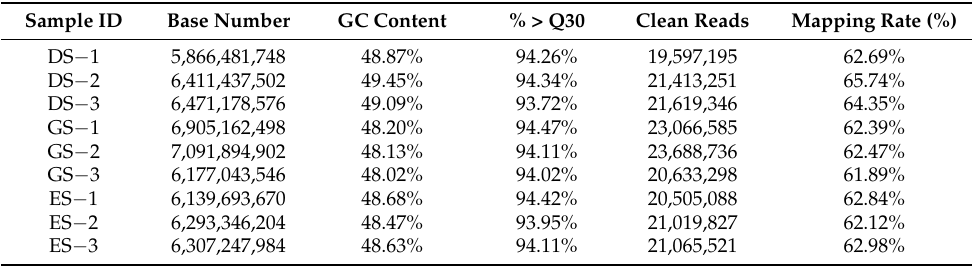
Table 1. Summary of generated RNA-seq data.